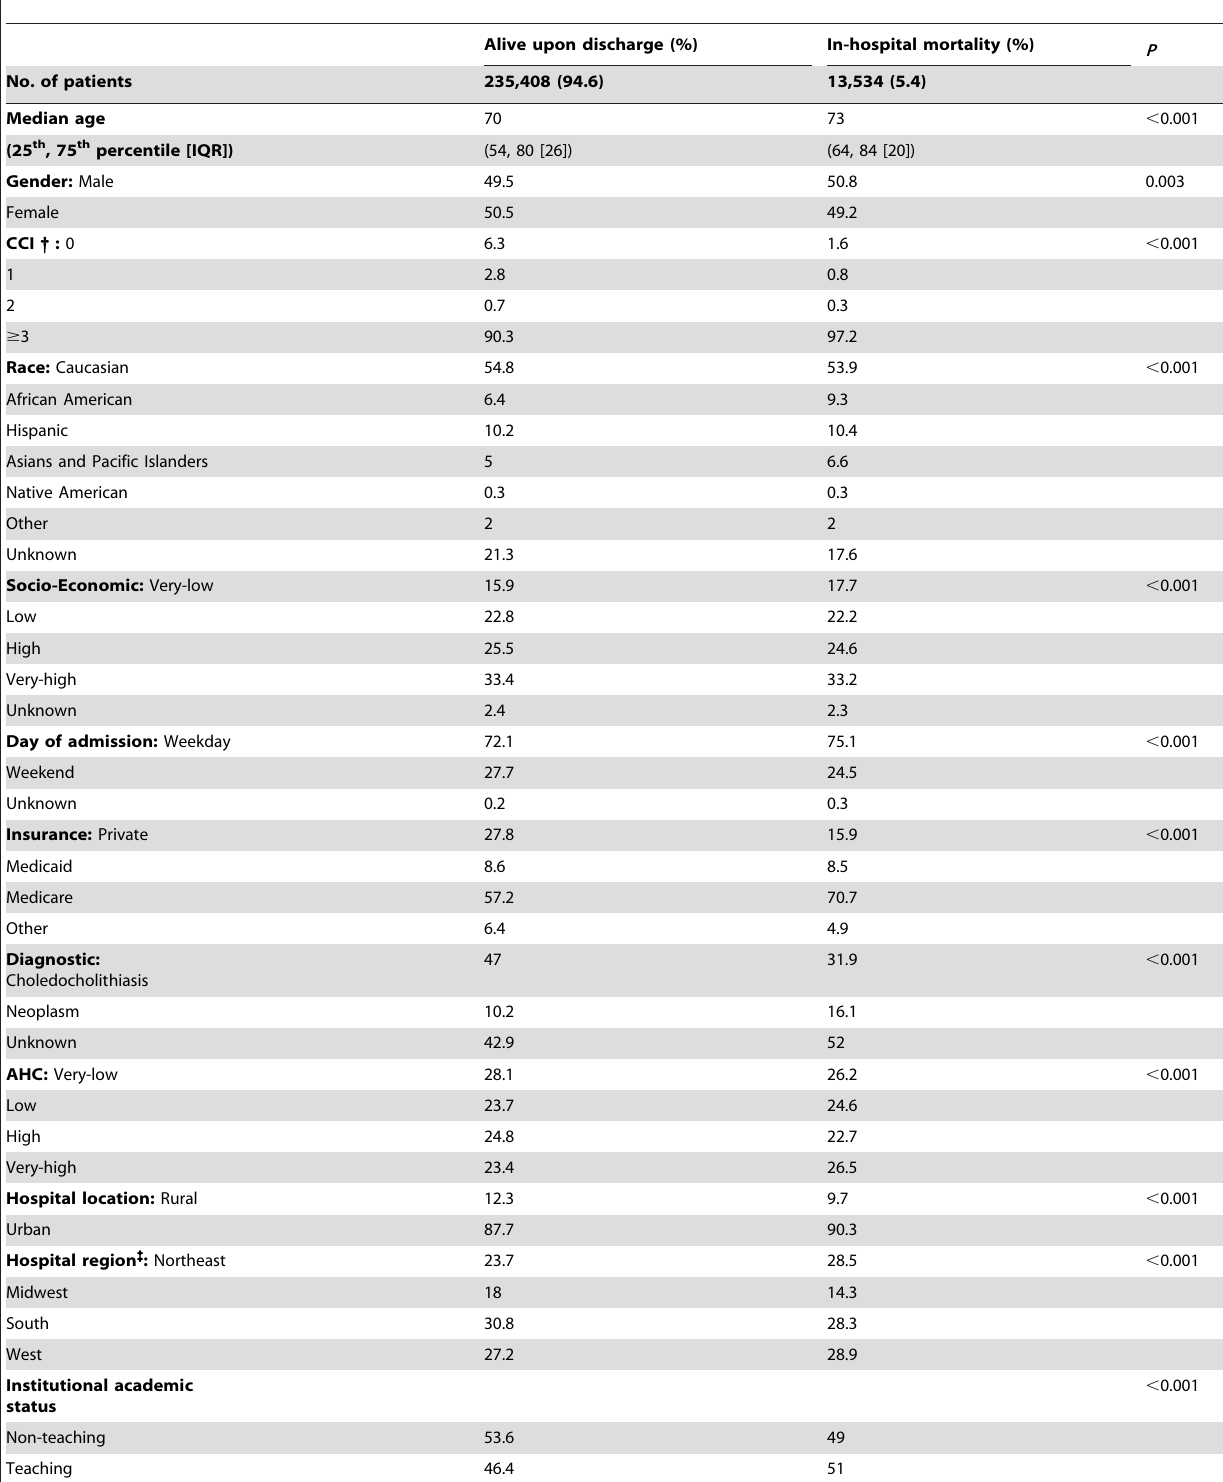
Table 2. Weighted demographic characteristics of patients admitted with cholangitis, stratified according to in-hospital mortality, Nationwide Inpatient Sample, 1998–2009.